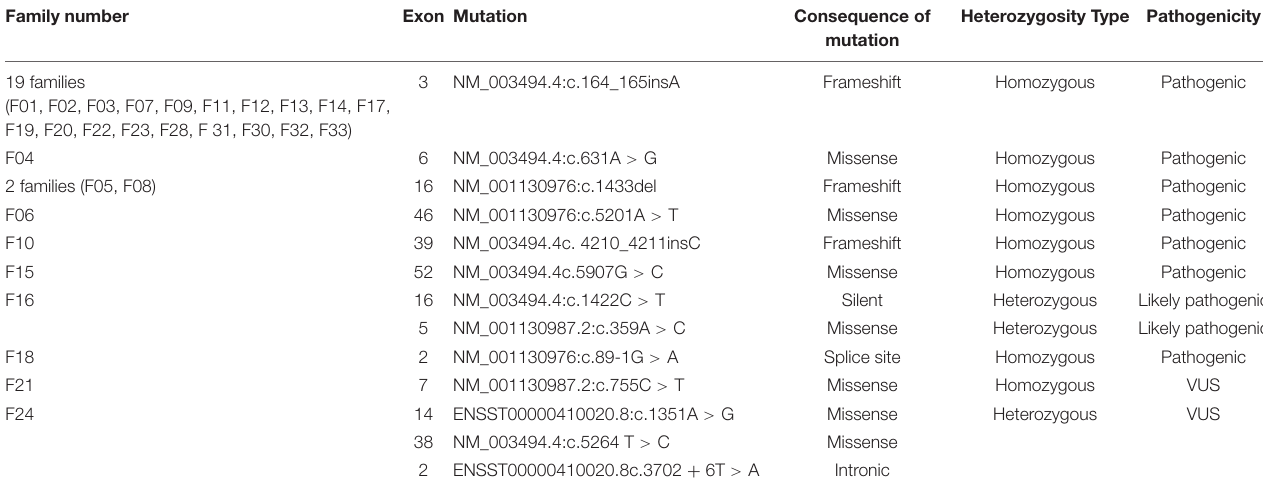
TABLE 3 | Mutations identified in Saudi Arabian LGMDR2 cohort: ( n = 29). Family number Exon